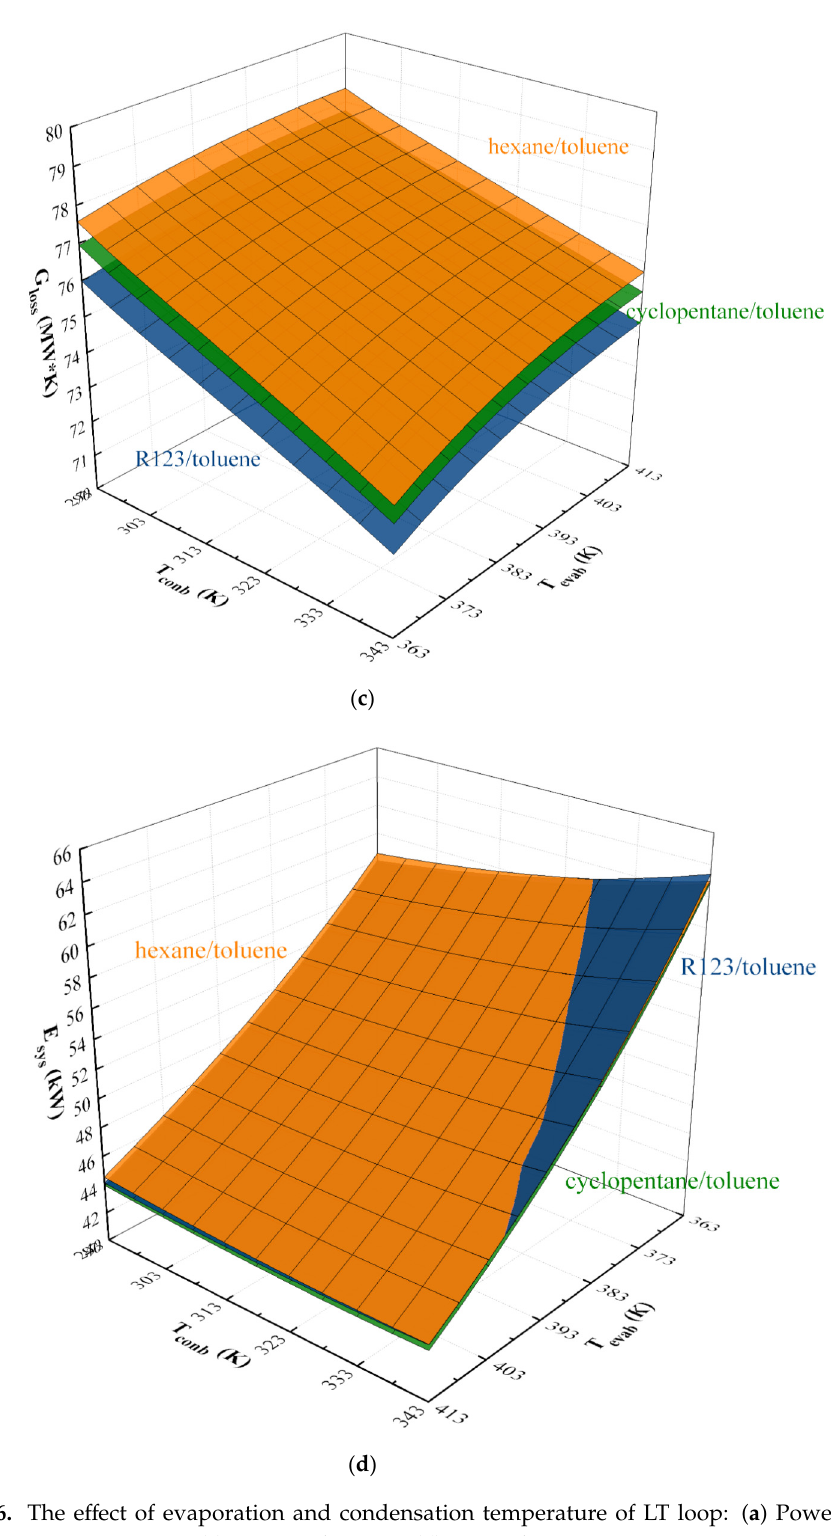
Figure 6. The effect of evaporation and condensation temperature of LT loop: ( a ) Power output; ( b ) entropy generation rate; ( c ) entransy loss rate; ( d ) exergy loss.